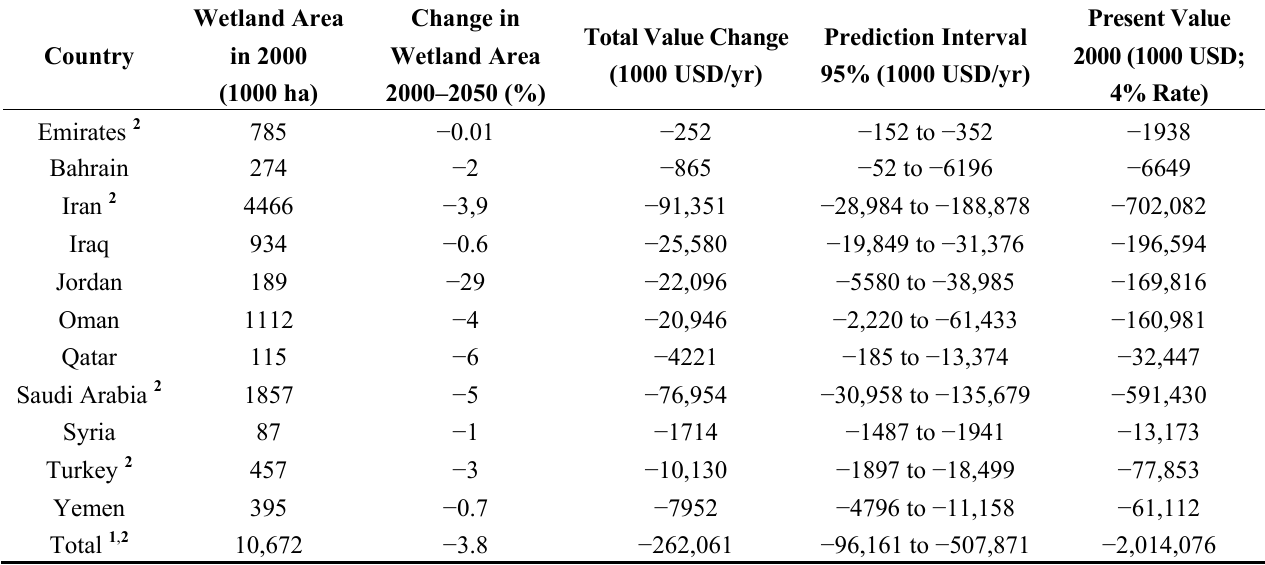
Table 3. Change in wetland area and value in West Asia by country